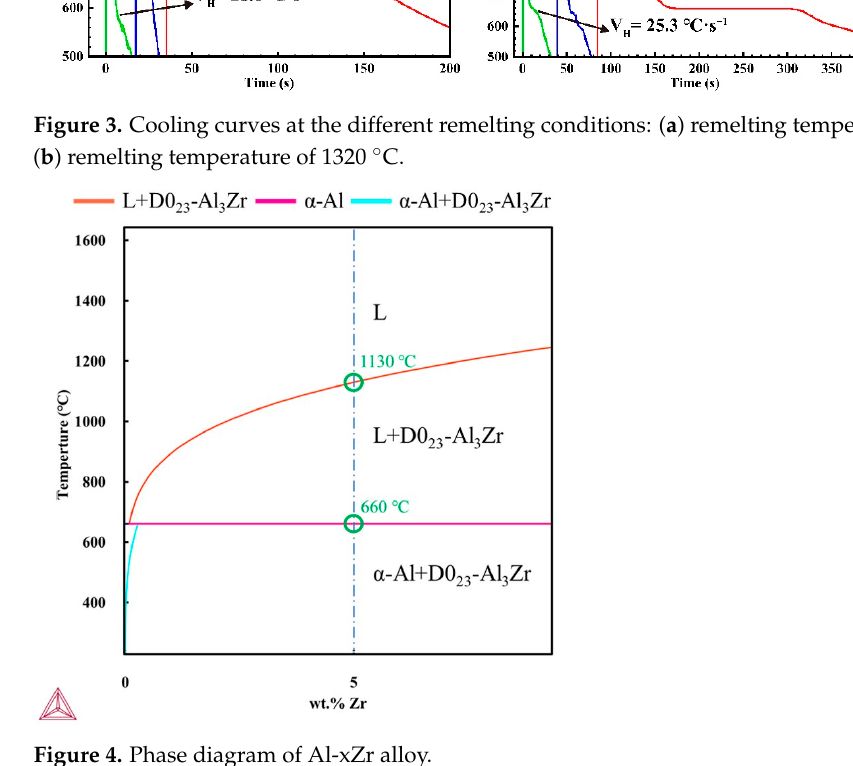
Figure 4. Phase diagram of Al-xZr alloy.